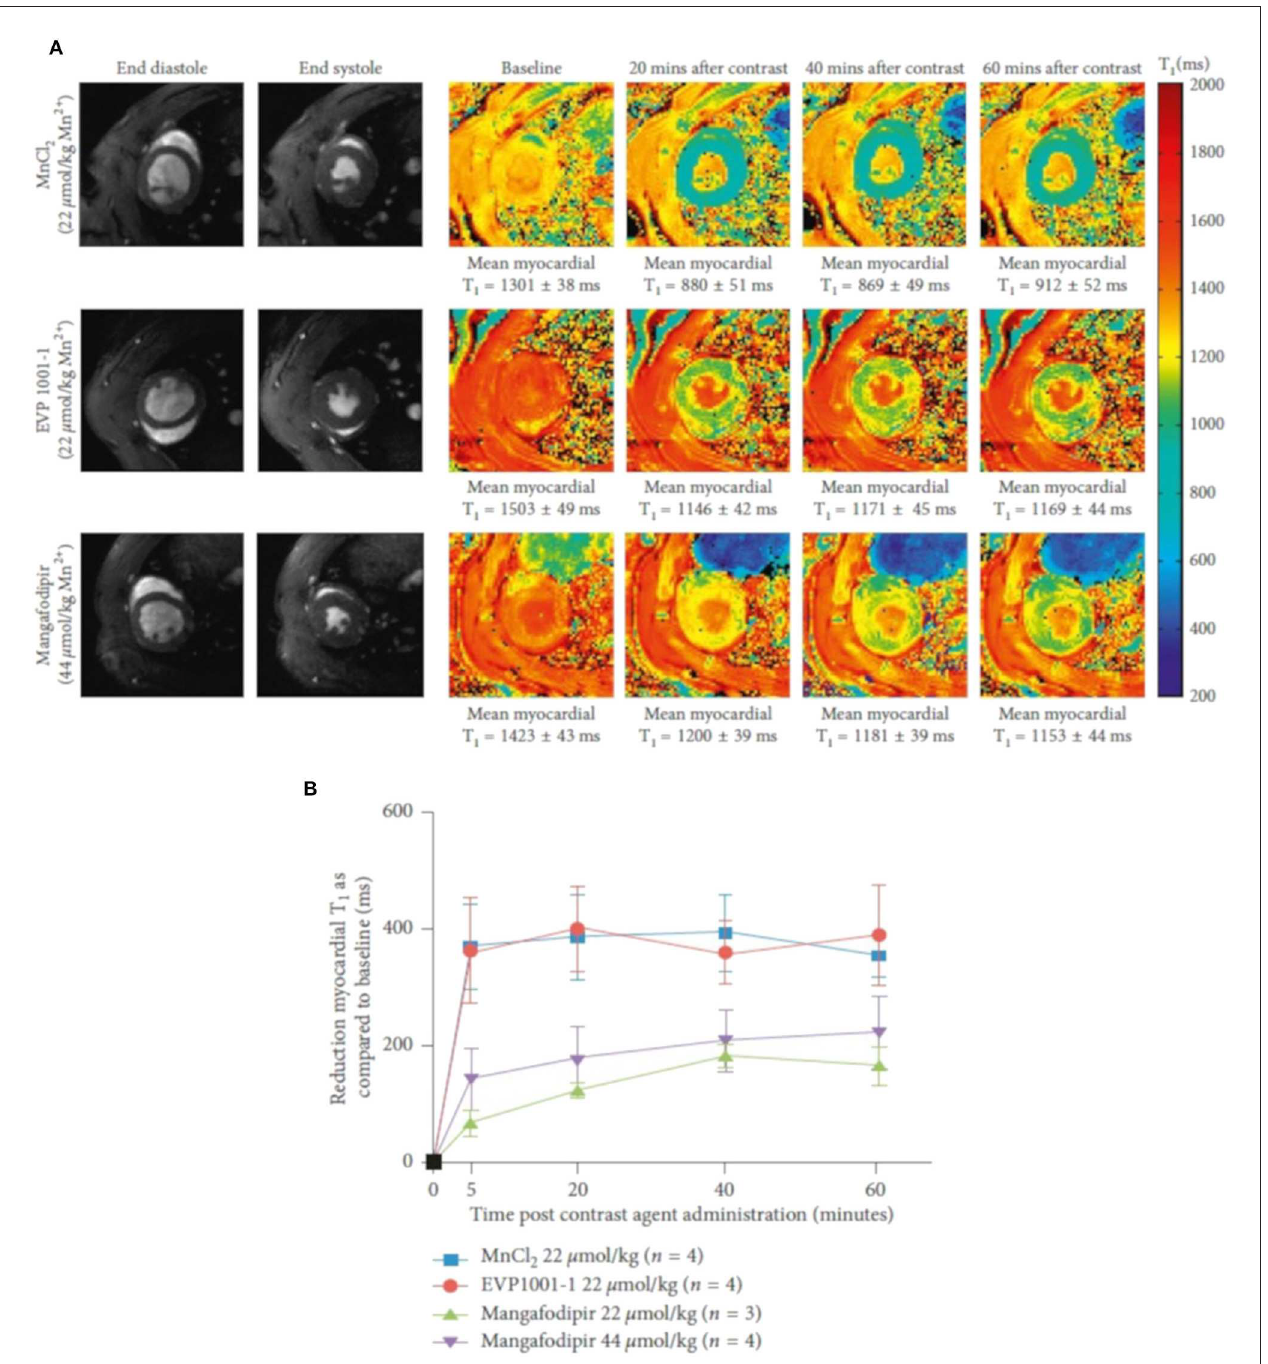
FIGURE 11 | T1 shortening with different manganese contrast media over time. (A) Normalized T1 maps acquired subsequent to infusion of MnCl 2 , EVP1001-1, and mangafodipir at 20min intervals up to 60min. A clear decreased myocardial T1 value could be observed in all groups. (B) Reduction in mean left ventricular T1 values over 60min with MnCl 2 , EVP1001-1 and different concentrations of mangafodipir. Two-way ANOVA confirmed a dependence of mean myocardial T1 shortening between each of the contrast agents ( P < 0.0001). Reproduced with permission from Spath et al. [184].